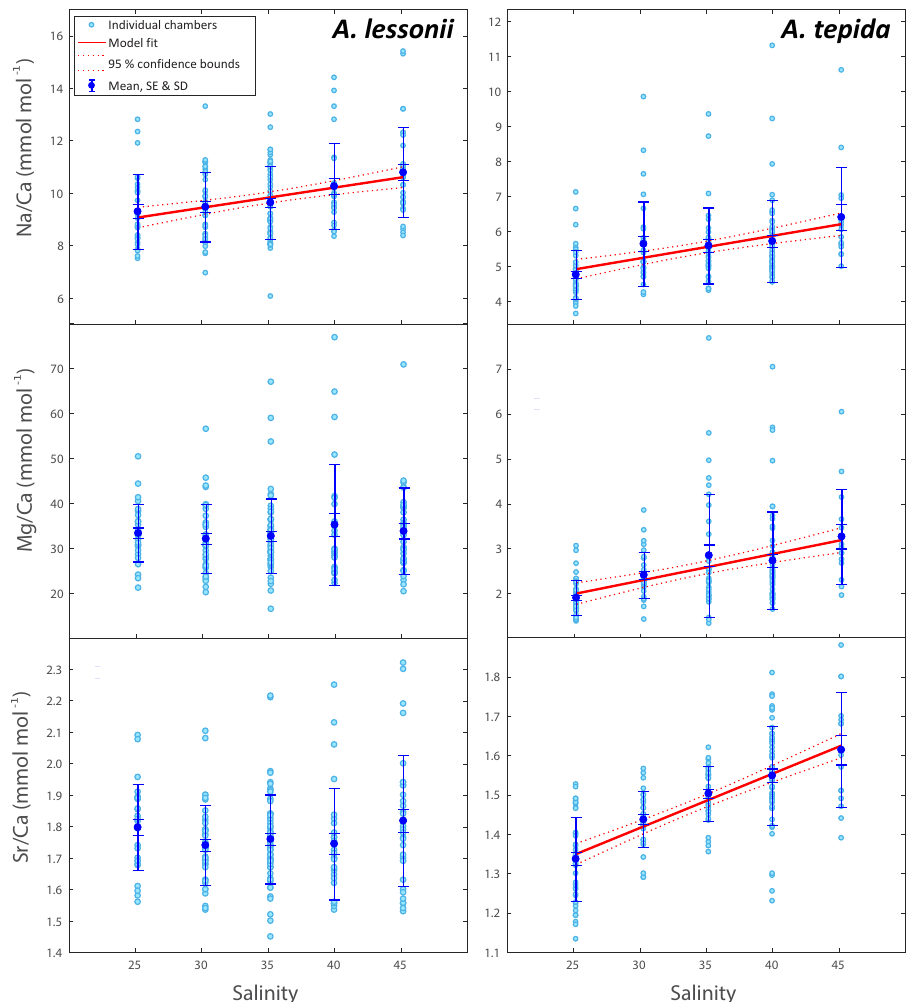
Figure 1. Foraminiferal Na / Ca cc , Mg / Ca cc and Sr / Ca cc versus salinity. Light blue dots represent the average per specimen ( n = 359 for A. lessonii , n = 339 for A. tepida , with 2–3 measured chambers per individual) and dark blue dots indicate the mean, with inner error bars indicating the standard error and outer error bars the standard deviation for each treatment. The linear regression model (red line) is based on the mean of individuals, with the 95% confidence interval of the regression in dashed